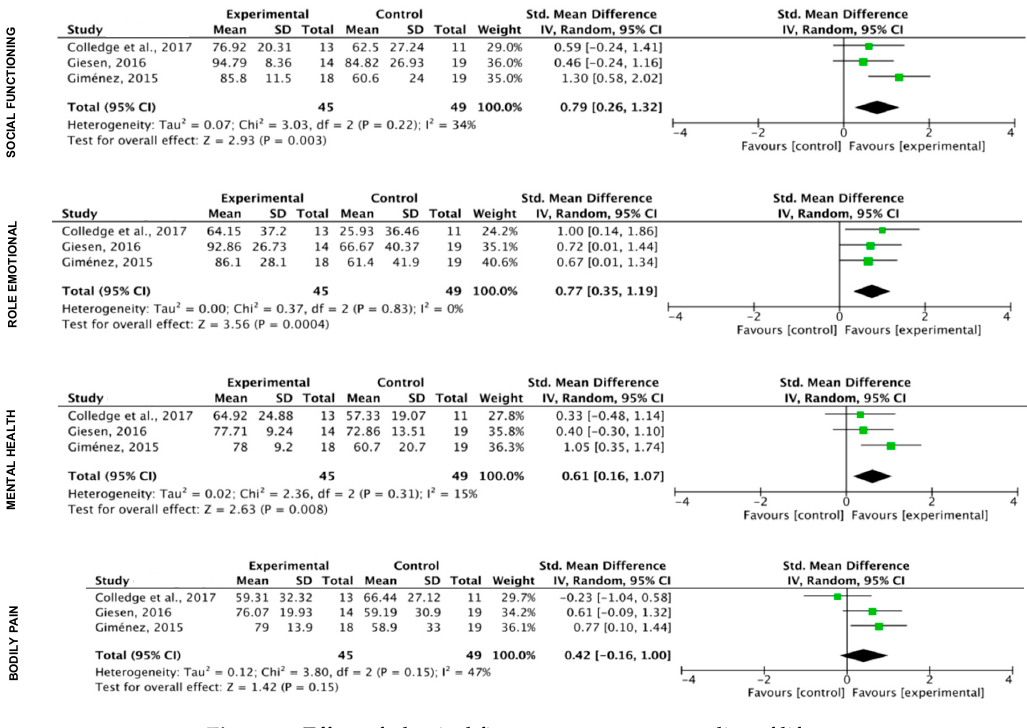
Figure 6. Effect of physical fitness programs on quality of life.